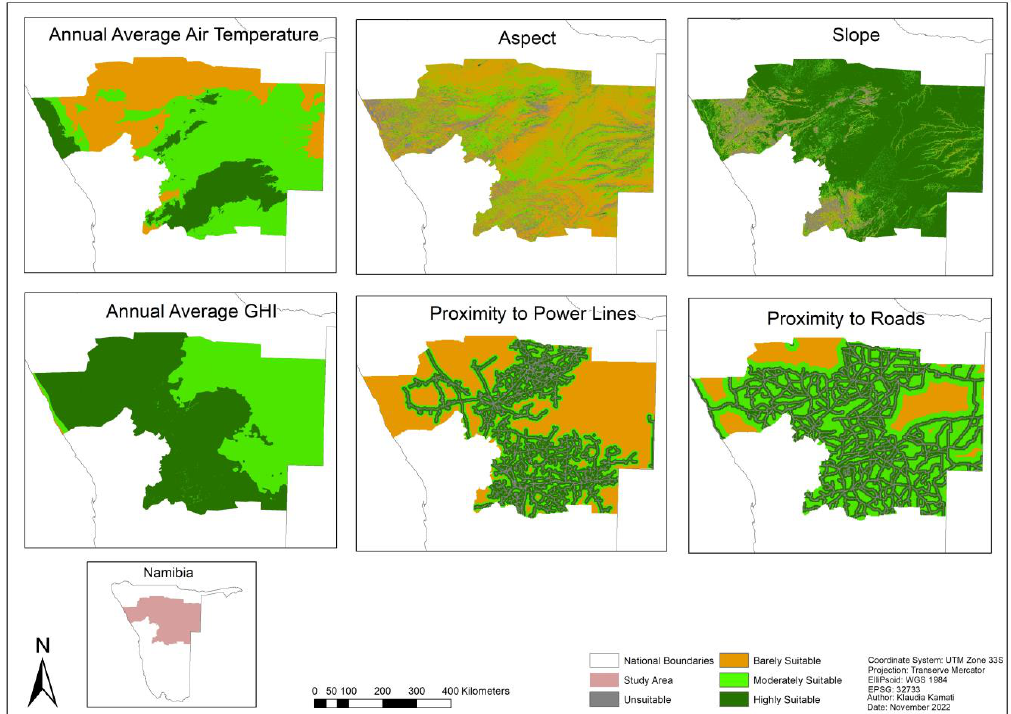
Table 5. Factors involved in installing solar PV systems.